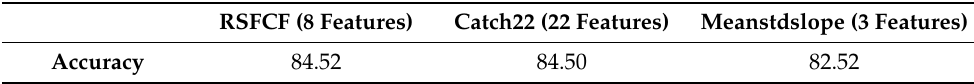
Table 3. Ablation experiment result.